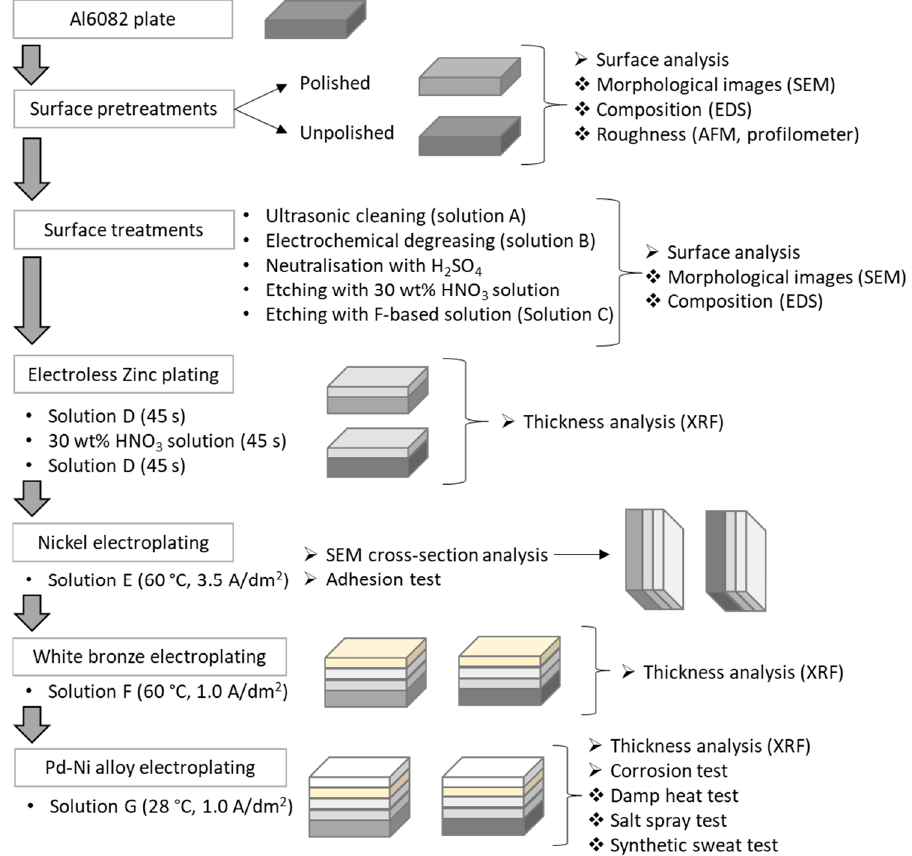
Figure 1. Flowchart of the depositions and characterizations performed in this study.